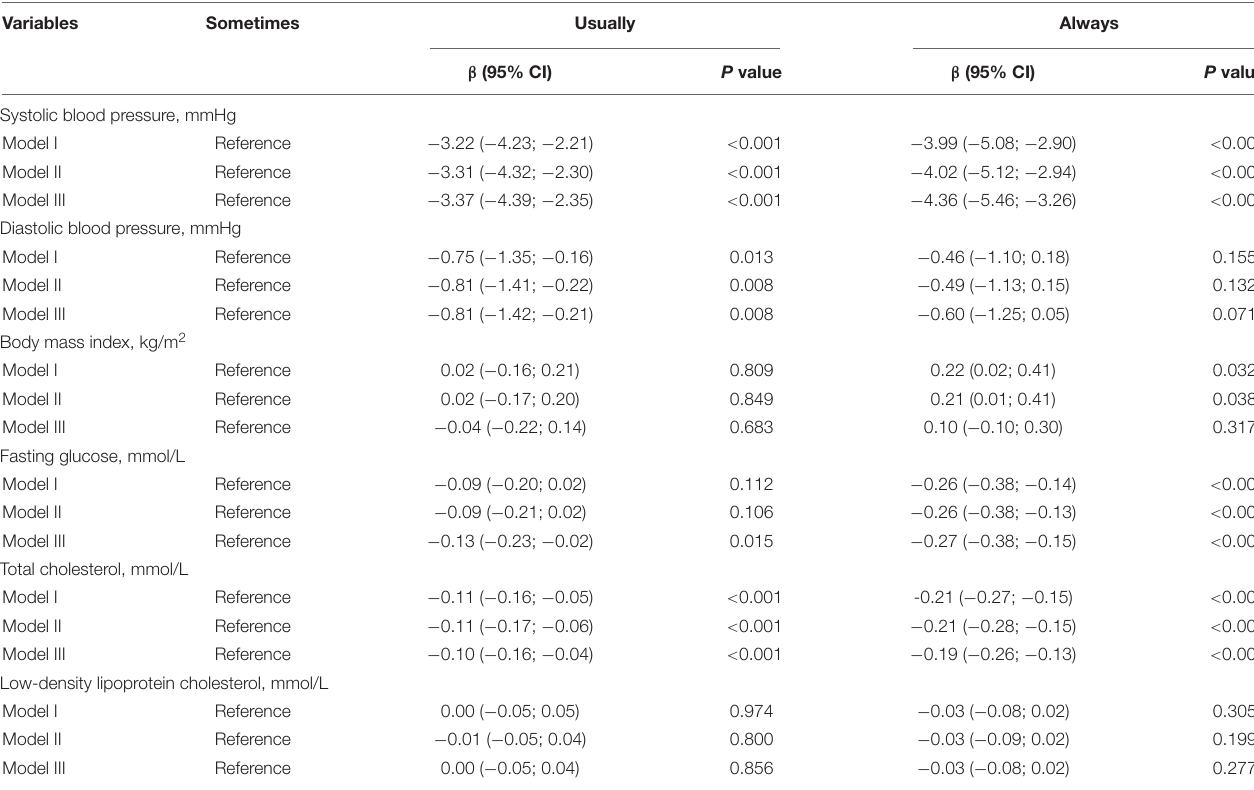
TABLE 3 | Multivariable linear regression analysis of the association between the frequency of annual health check participation and the control of cardiovascular risk factors. Variables Sometimes Usually